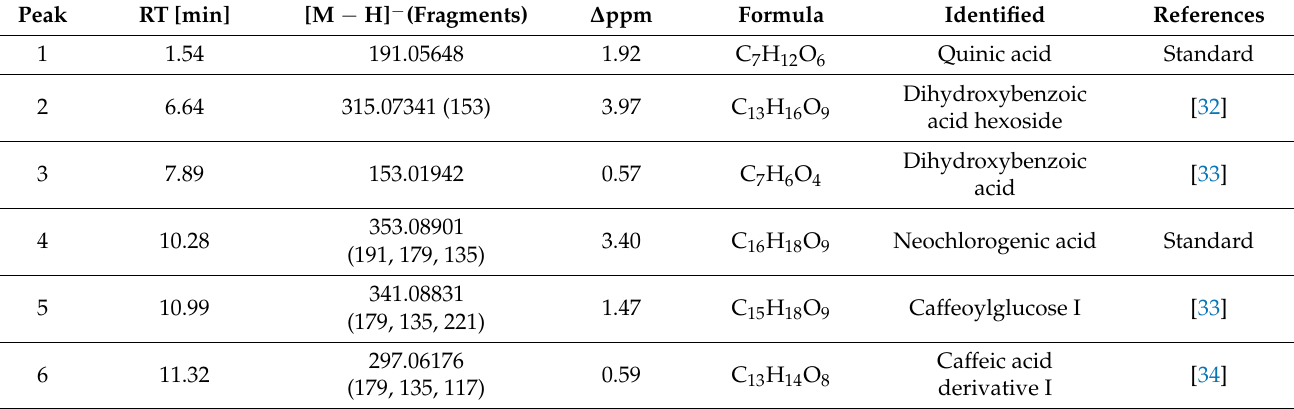
Figure 1. Total content of phenolics ( a ), flavonols ( b ), and anthocyanins as cyanidin 3-glycoside, C3G ( c ) and free radical scavenging activity ( d ) of P. amboinicus leaf and stem extracts, depending on the form of chitosan in the solution used for spraying the plants (CHT—chitosan suspension; CHL—chitosan lactate). Mean values ( ± standard deviation; n = 3) marked with different letters were statistically significantly different ( p < 0.05). The absence of a letter designation means the absence of statistically significant differences. Table 1. MS data of components identified in the P . amboinicus leaf samples in negative ionisation mode.